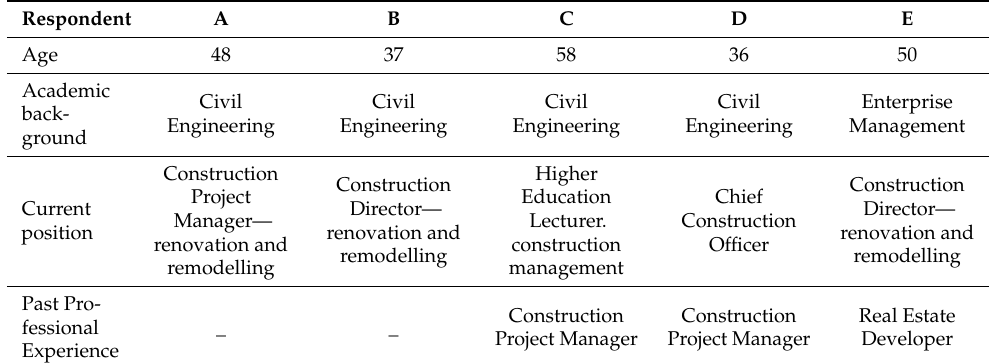
Table 1. Interviewees characterization